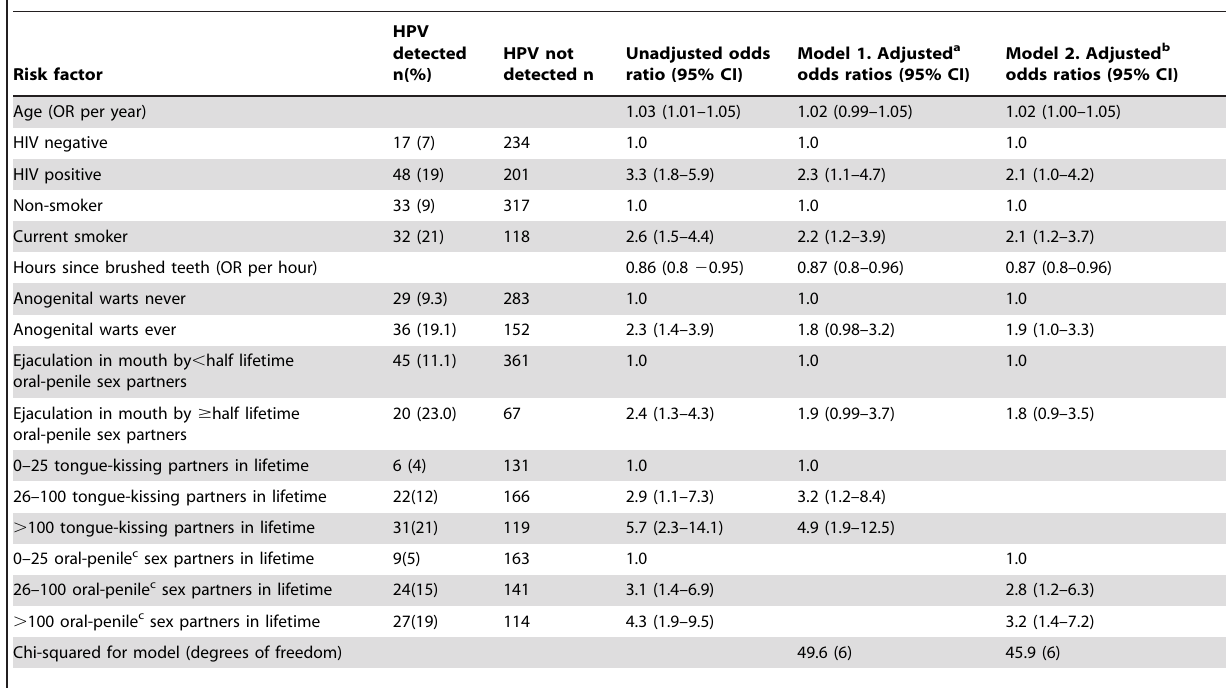
Table 4. Factors associated with detection of HPV in the oropharynx.